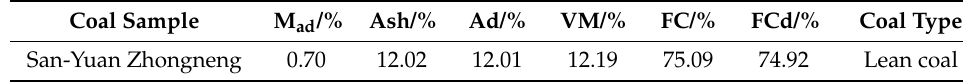
Table 1. Proximate analysis of coal sample.